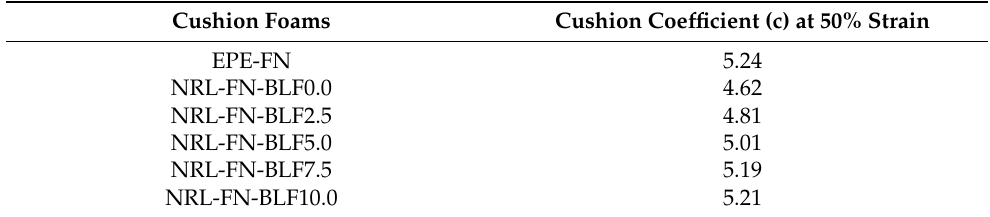
Table 3. Cushion coefficient at 50% strain of a commercial cushion foam compared to the eco-friendly cushion NRL-FN at various BLF